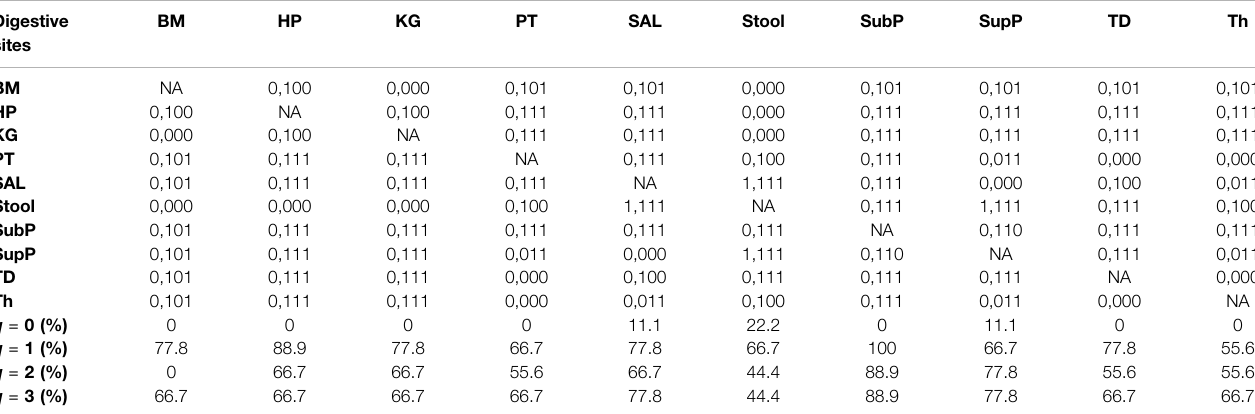
TABLE 2 | Summary of the randomization tests from Supplementary Table S7 : the pair-wise comparisons of the DAR parameter ( D max : potential diversity) among the ten DT sites of the human digestive microbiome (Genus level) for each diversity order q . The same coding scheme as in Table 1 was used. Digestive sites